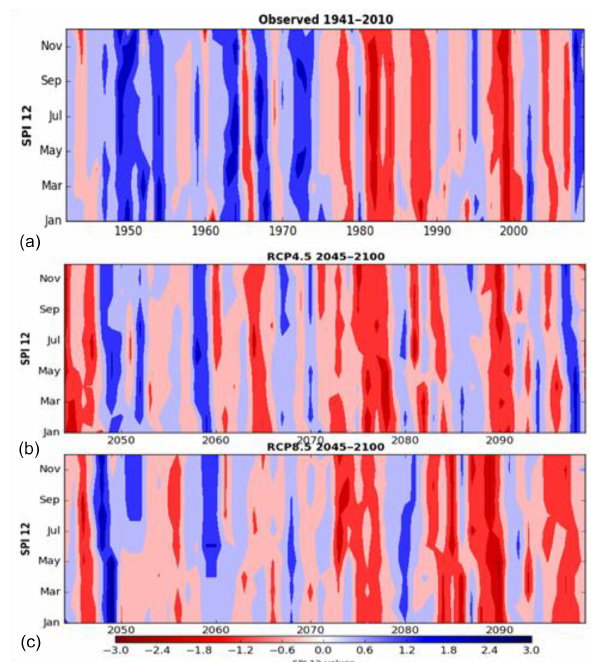
Figure 2. Temporal variation of meteorological drought (SPI 12) in the Beni Bahdel Dam catchment. (a) SPI-12 derived from observed precipitation (1941–2010), and (b, c) SPI-12 derived from the pro- jected precipitation by the RCA4-MPI-ESM-LR climate model for the RCP4.5 and RCP8.5 scenario, respectively, period